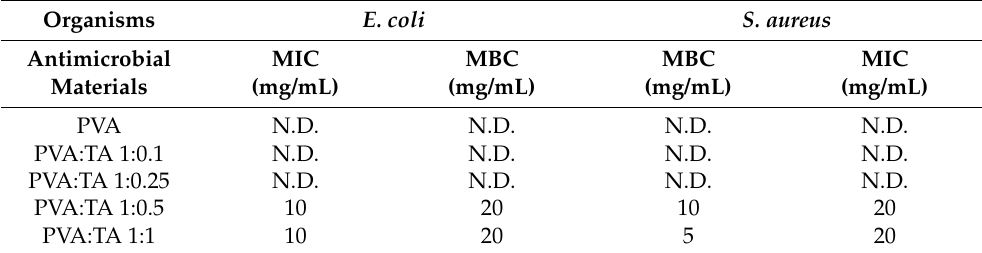
Table 3. Minimum inhibition concentration (MIC) and minimum bactericidal concentration (MBC) values of PVA cryogels at a single concentration and PVA:TA cryogel composites at different amounts against E. coli and S. aureus strains. Organisms E. coli S. aureus